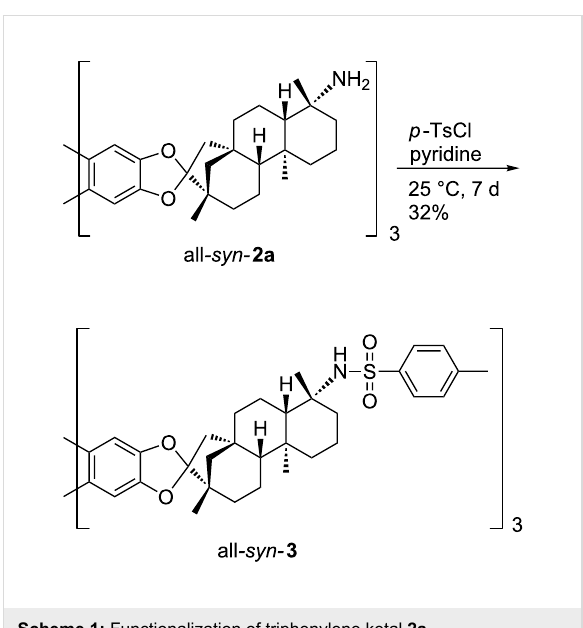
For the elaboration of optimal condensation conditions to